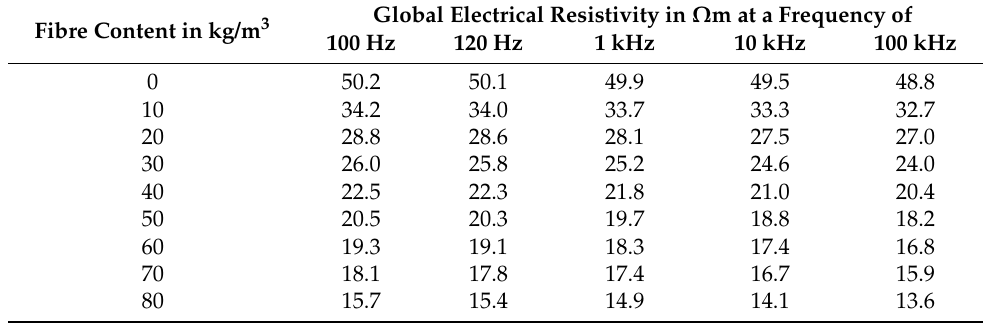
Table A13. Results of the resistivity measurements of the concrete mixture 32-60-270-00.